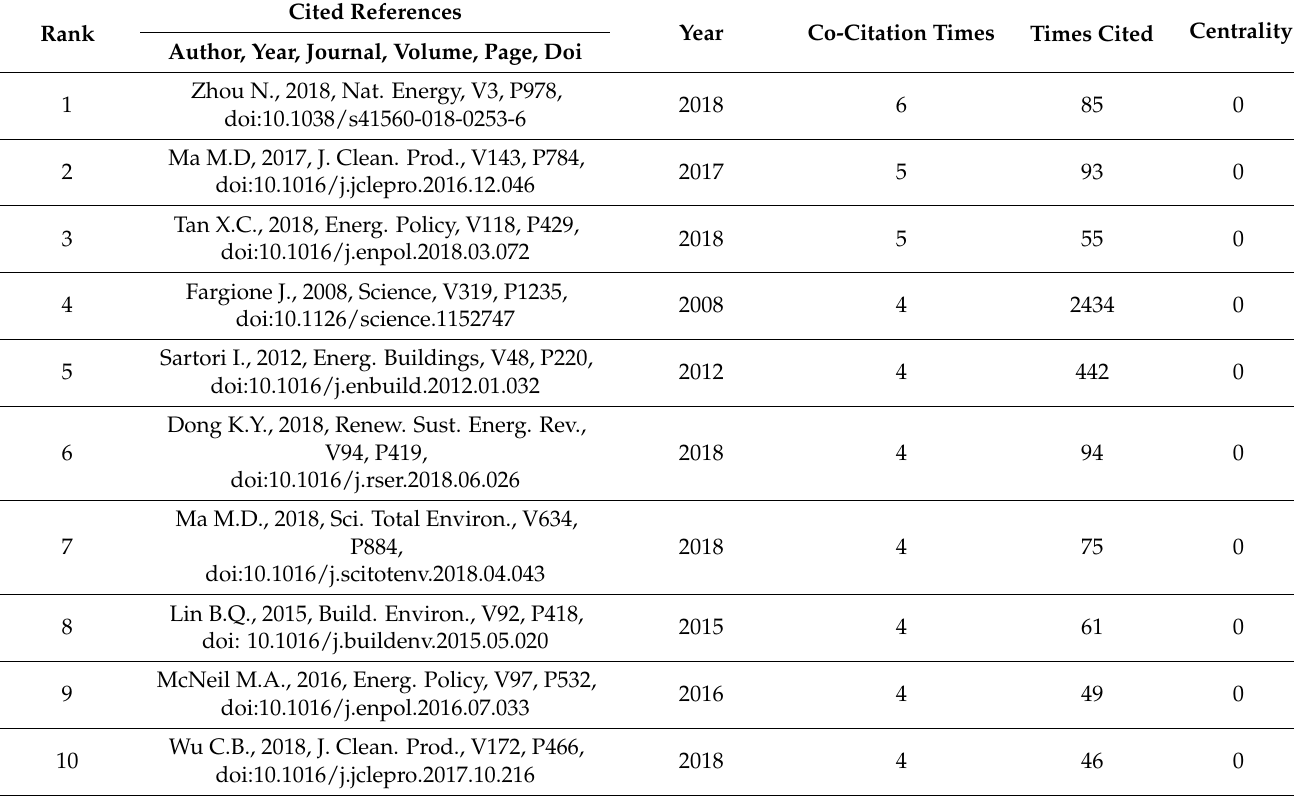
Table 8. The top 10 most co-cited